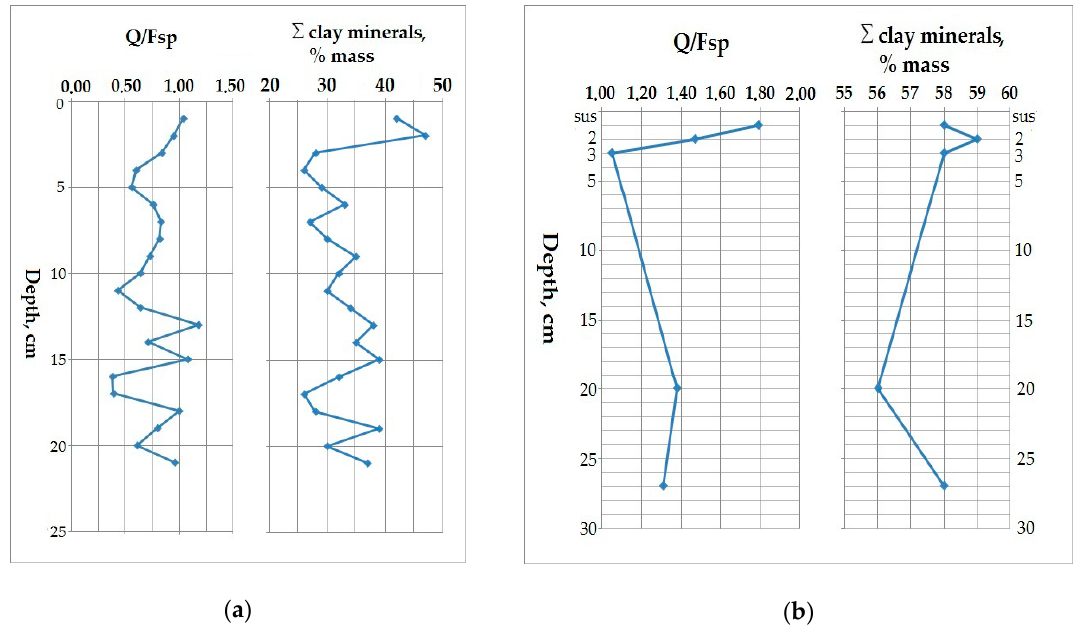
Figure 22. Downcore change in the quartz-feldspar ratio (Q / Fsp) and total content of minerals of the clay group in the AMK-5454 core, the Cambridge Strait, Franz Josef Land ( a ), and in the AMK-5424 core, the Russkaya Gavan’ Bay, the Novaya Zemlya Archipelago ( b